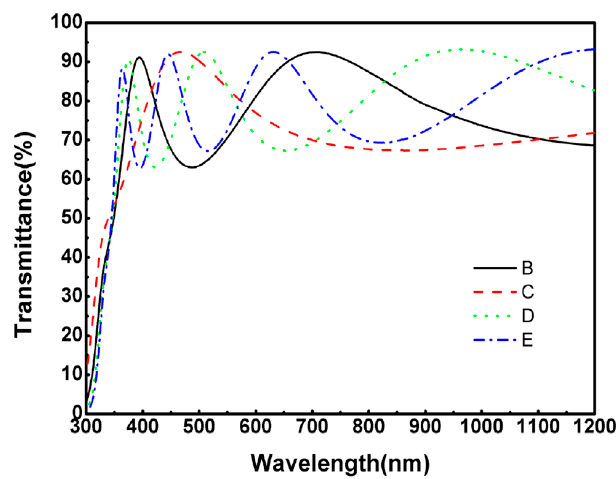
Figure 6. Transmittance spectra of niobium oxide (Nb 2 O 5 ) films deposited at different cathode power [90].